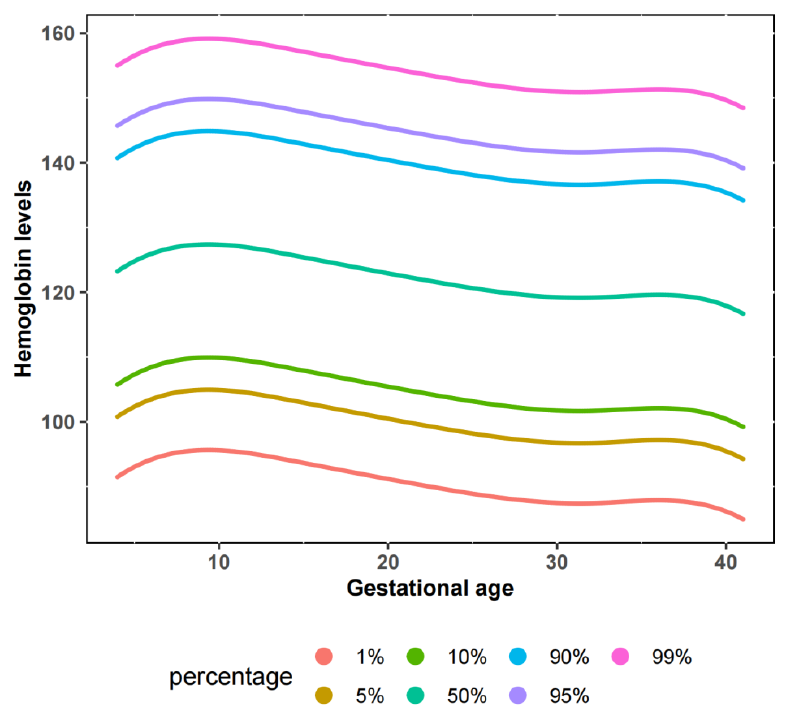
Figure 2. Estimated 1st, 5th, 10th,50th, 90th, 95th, and 99th percentiles for hemoglobin concentration by gestational age. Restricted cubic spline was performed to reveal a non-linear variation of hemoglobin concentrations during the gestational week.